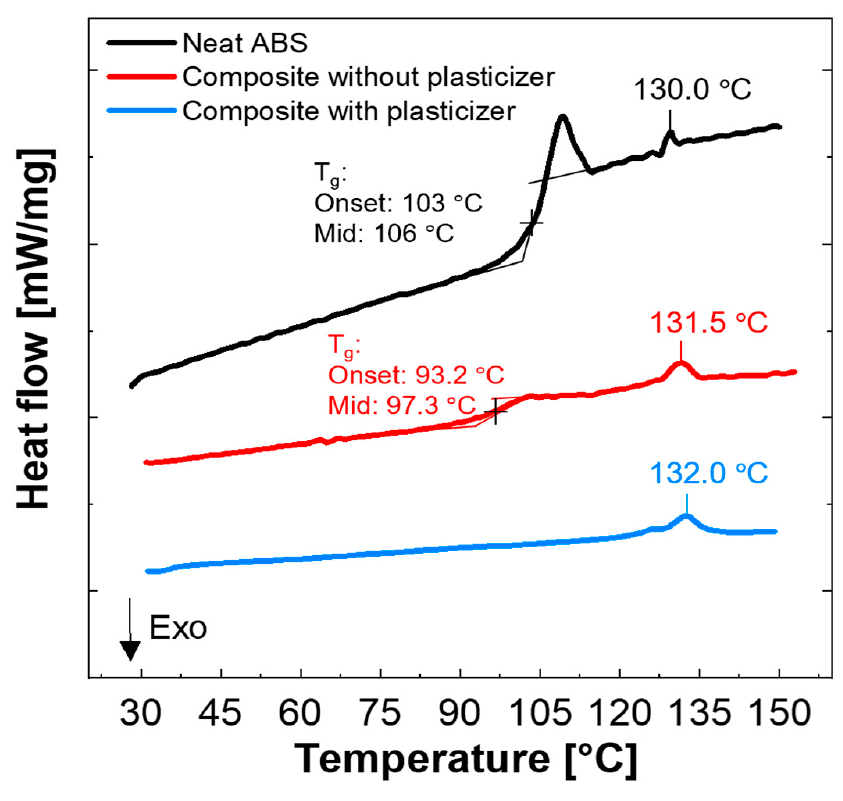
Figure 6. DSC heating curves of neat ABS and ABSc without and with plasticizer (10 °C/min, nitrogen).